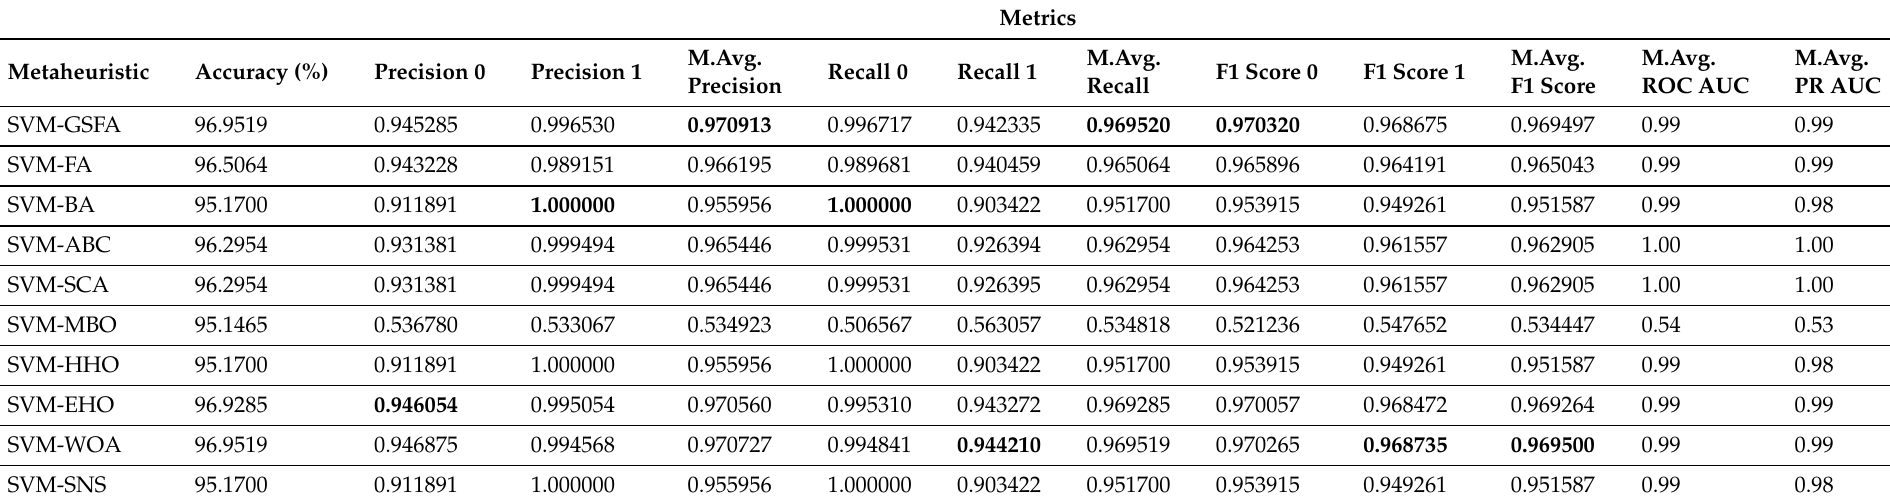
Table 11. SVM Credit Card Fraud small with the SMOTE—detailed metrics.